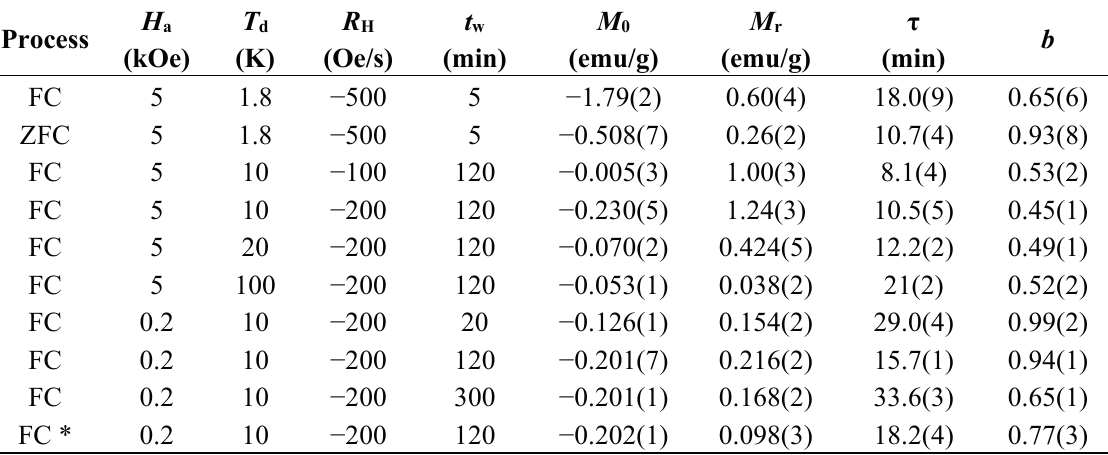
Figure 7. ( a ) Comparison of the temporal evolution of the induced inverse magnetizations after wait times of 20 min (open triangles), 120 min (filled circles) and 300 min (open squares), through field-cooling at H a = 200 Oe from 300 to 10 K and a field reduction of R H = − 200 Oe/s; and ( b ) temporal evolution of the inverse magnetization recorded upon reaching 10 K (open triangles) and when the H a is completely off (filled circles), in the process of field-cooling at H a = 200 Oe from 300 to 10 K, followed by a wait time of t w = 120 min before turning the H a off at a rate of R H = − 200 Oe/s. The solid lines indicate the fits of the data to the exponential profile listed in (a). Table 1. Parameters obtained from the fits of the M i ( t ) curves to the expression waiting